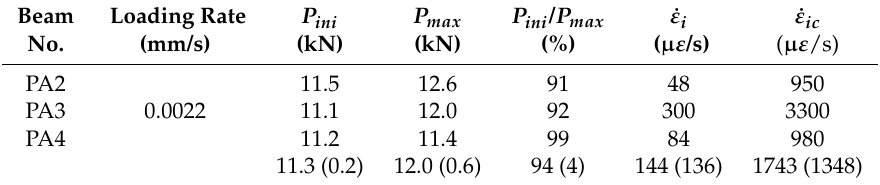
Figure 7. Typical load versus-strain curves recorded in SG1 for beams made from concrete PA ( left ), PB ( central ) and PC ( right ) loaded at 22 µ m/s (the 1st row), 22 mm/s (the 2nd row), 1.77 m/s (the 3rd row) and 2.66 m/s (the 4th row), respectively. Table 3. Measured impact load P max , P ini , the ratios between both, the strain rate upon the initiation of a cohesive crack ˙ ε i , and the strain rate upon the formation of a stress-free crack ˙ ε ic , the corresponding mean values with standard deviations shown in the parentheses are given in the fourth